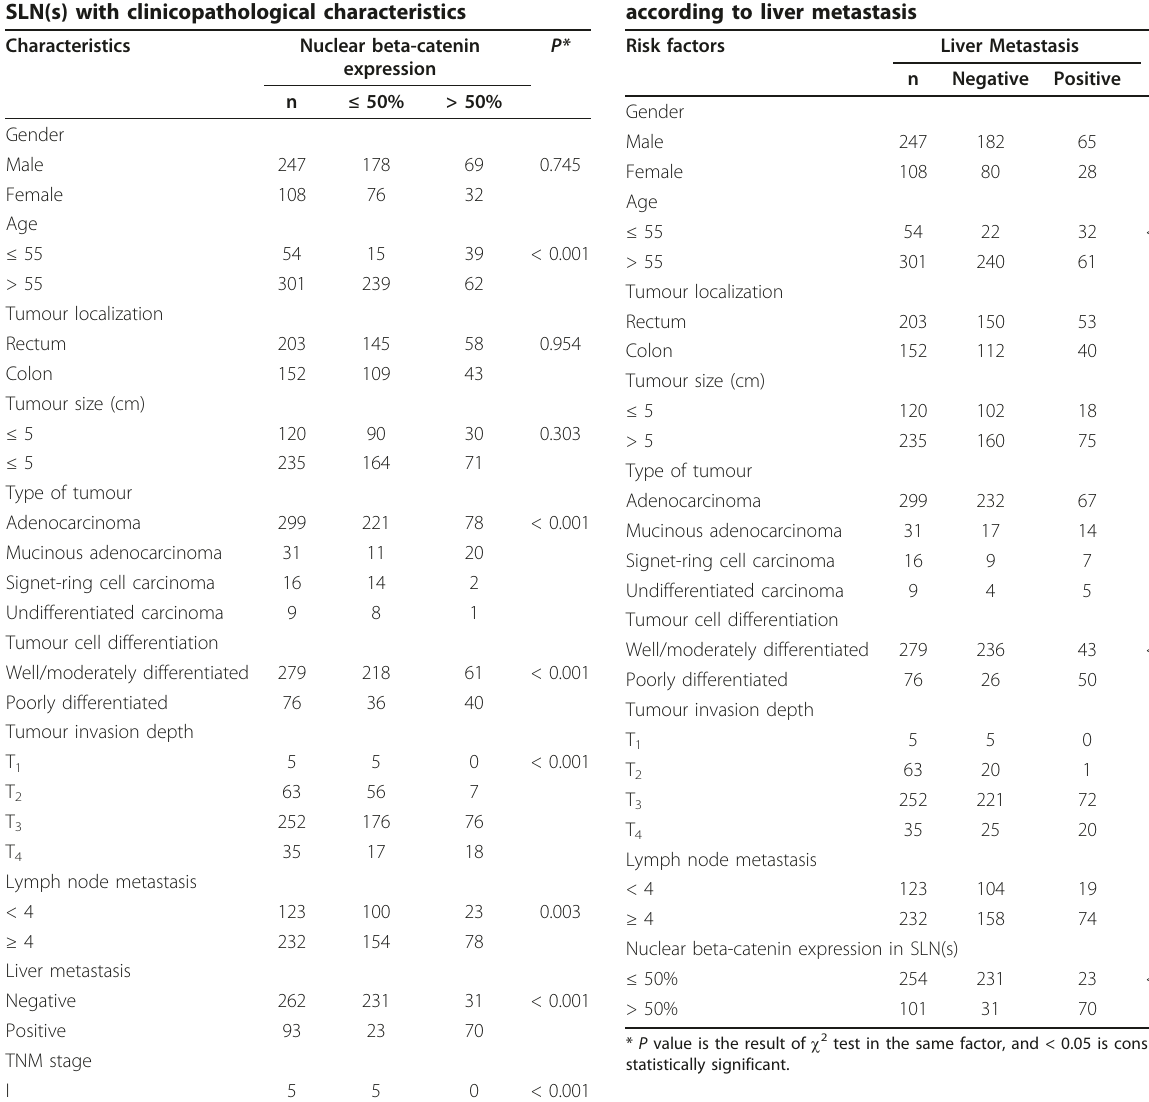
Table 3 Clinicopathological risk factors classified